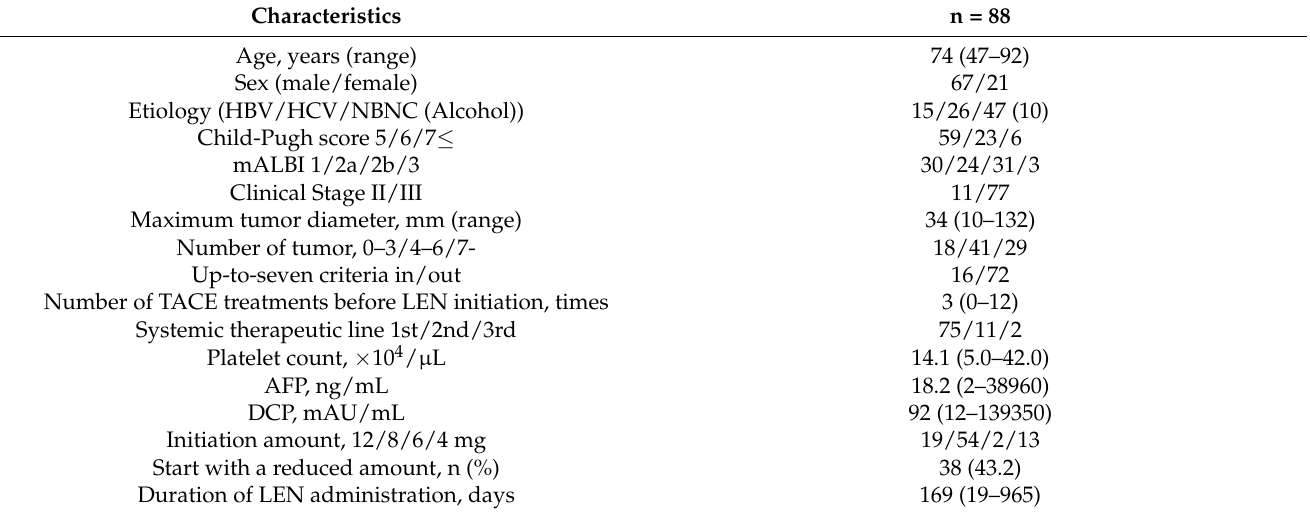
Table 1. Patient characteristics.